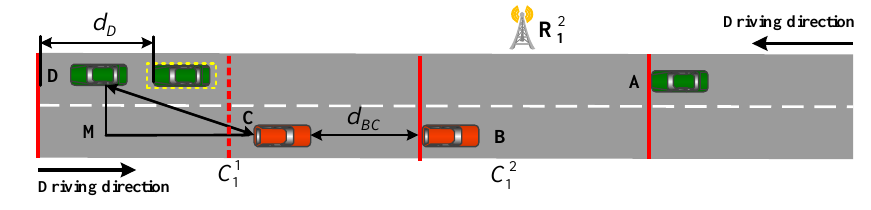
2 after time t 2 2 C after time 1 1 2 C after time 1